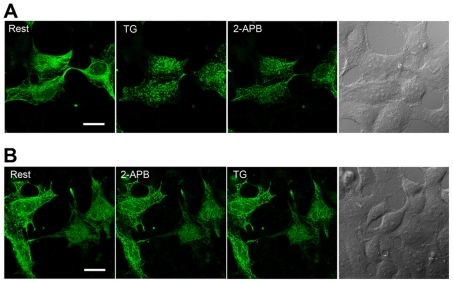
2-APB reverses or prevents BiFC-STIM1 relocalisation to puncta near the plasma membrane.HEK293T cells were cotransfected with VN173-ST1 and VC155-ST1 constructs. After 24 h, live cells were examined under a confocal microscope at the cell footprint. Part A: VN173-ST1 and VC155-ST1 coexpressed in HEK293T cells redistributed from a fibrillar appearance (Rest) to puncta at the cell periphery after Ca2+ store depletion with TG. Puncta were visible at the cell footprint. The addition of 50 µM 2-APB rapidly reversed the relocalisation of BiFC-STIM1 to plasma membrane puncta (2-APB). Part B: 2-APB prevented BiFC-STIM1 relocalisation to puncta near the plasma membrane. Confocal imaging was carried out in experiments in which cells expressing BiFC-STIM1 were pretreated with 50 µM 2-APB for 5 min prior to store depletion with TG. Scale bars, 20 µm.